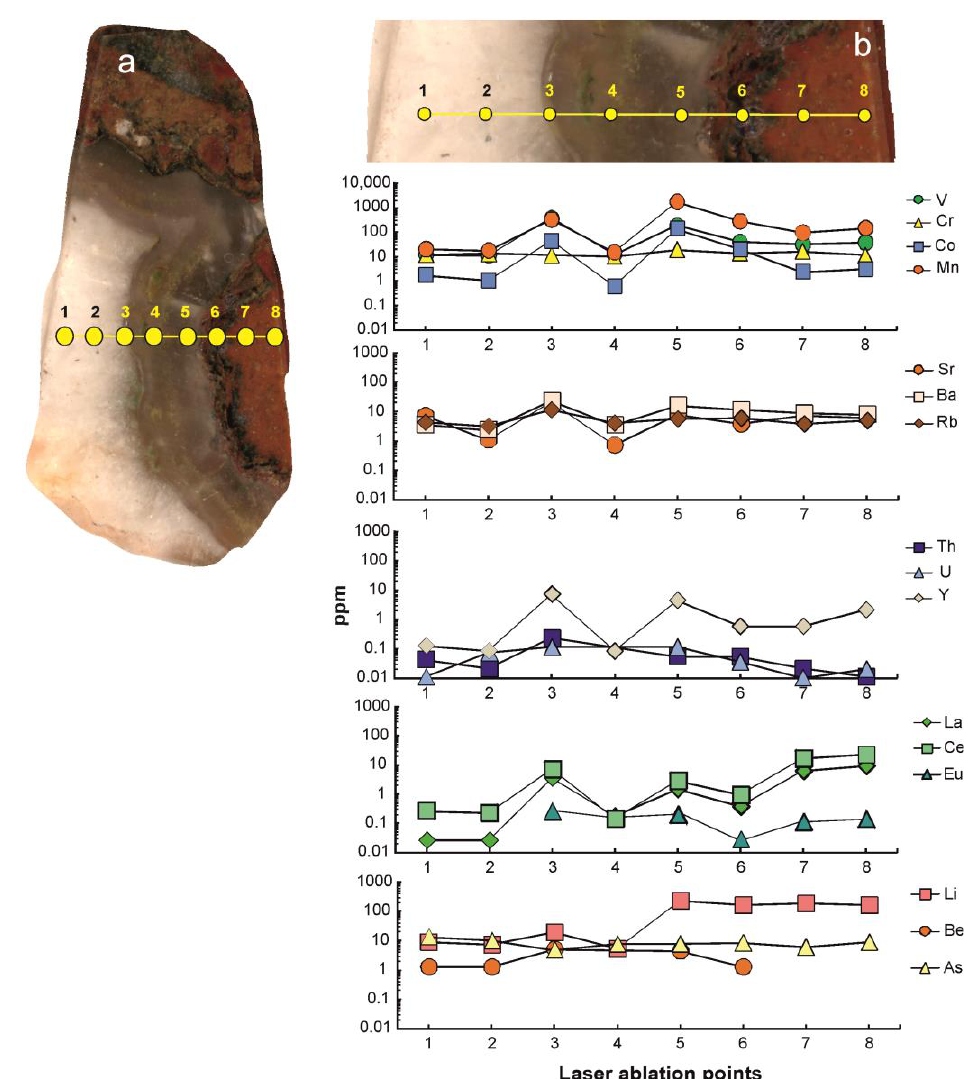
Figure 9. Micrograph of an agate from Pinguba occurrence with a profile showing the analytical points of trace element analysis by LA-ICP-MS ( a ); distribution profiles of certain trace elements in the investigated agate ( b ). Points: 1, 2—macrocrystalline area; 3–5—chalcedony zone; 6–8—outer colored zone.